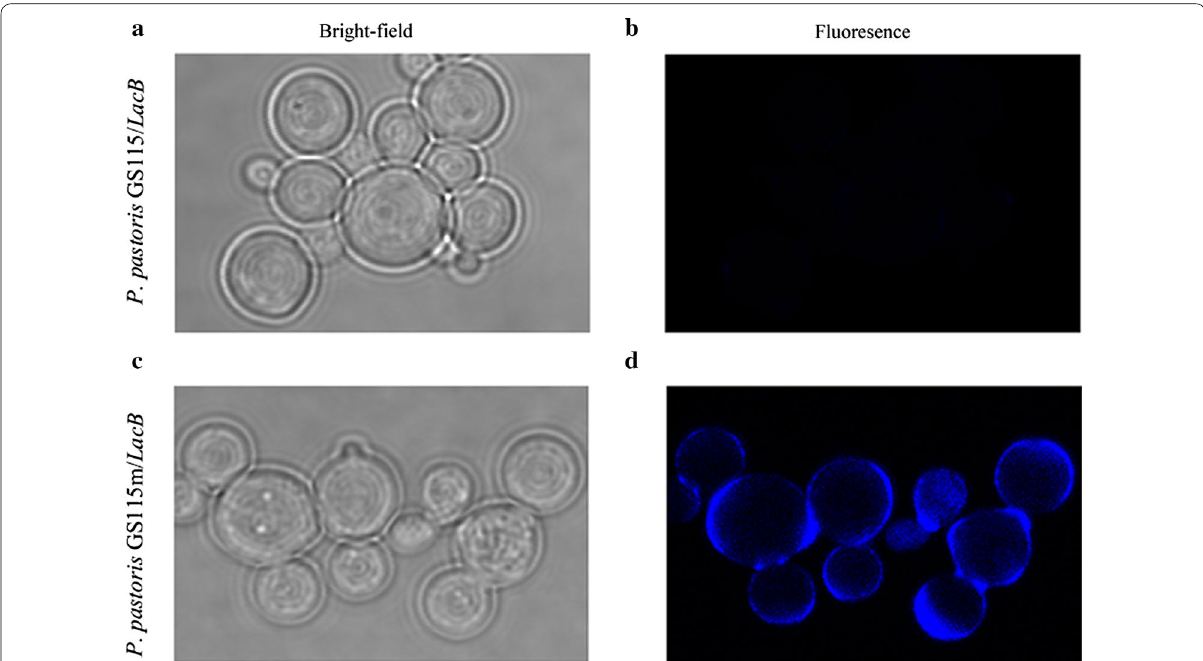
Fig. 6 Autophagy profiles in P. pastoris GS115/ LacB and P. pastoris GS115m/ LacB cells. The two strains were grown in YPR to an OD 600 of ~ 2, and then visualized by laser scanning confocal microscope with a 405 nm excitation wavelength and an emission wavelength shifting from blue